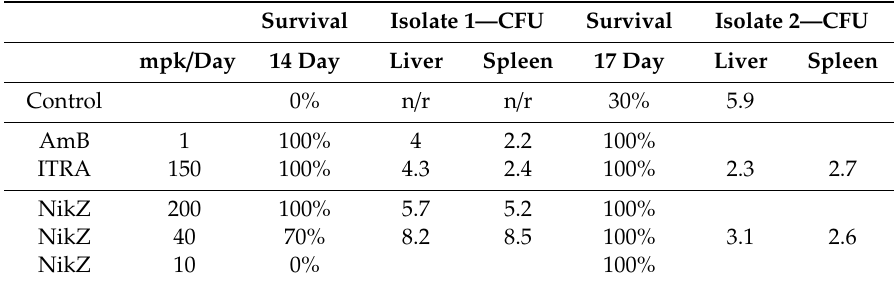
Table 6. pulmonary (intratracheal) histoplasmosis [41]: survival, organ burden (log10 CFU), two isolates. Inoculate, + 4, treat 10 days, + 1 or + 4, Inoculate: isolate 1–100K CFU (NikZ MIC ≥ 64 µ g / mL), Isolate 2–500K CFU (NikZ MIC 4 µ g / mL). Survival Isolate